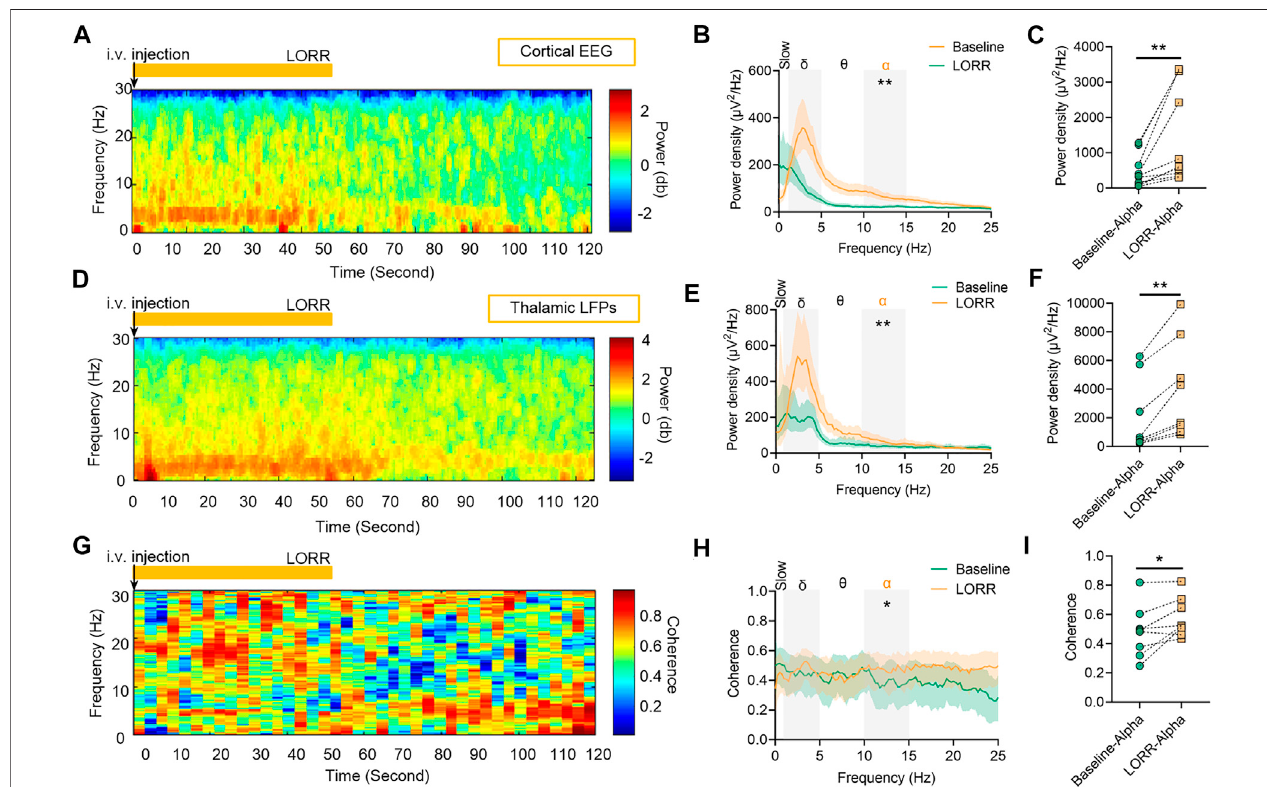
FIGURE4| DynamicsofcorticalEEGandthalamiclocal fi eldpotentials(LFPs)underpropofolanesthesia. (A) RepresentativespectrogramsofcorticalEEGand (D) thalamic LFPs. Propofol dosing starts at t = 0, and the vertical orange lines mark behavioral events (LORR). (B) Relative power density of cortical EEG and (E) thalamic LFPs. (C) Shading indicates 95% CI. The power density of cortical EEG and (F) thalamic LFPs in alpha oscillations. (G) Spectrogram of coherence between thalamic LFPs and cortical EEG. (H) Coherence between thalamic LFPs and cortical EEG. Shading indicates 95% CI. (I) Coherence of alpha oscillations between thalamic LFPsandcorticalEEG.Comparisonsarebasedonatwo-tailedpairedt-test:* p < 0.05and** p < 0.01.Frequency oscillations:slow(0.5 – 1 Hz),delta(1 – 5 Hz),andalpha (9 – 14 Hz). LFPs, local fi eld potentials; and CI, con fi dence